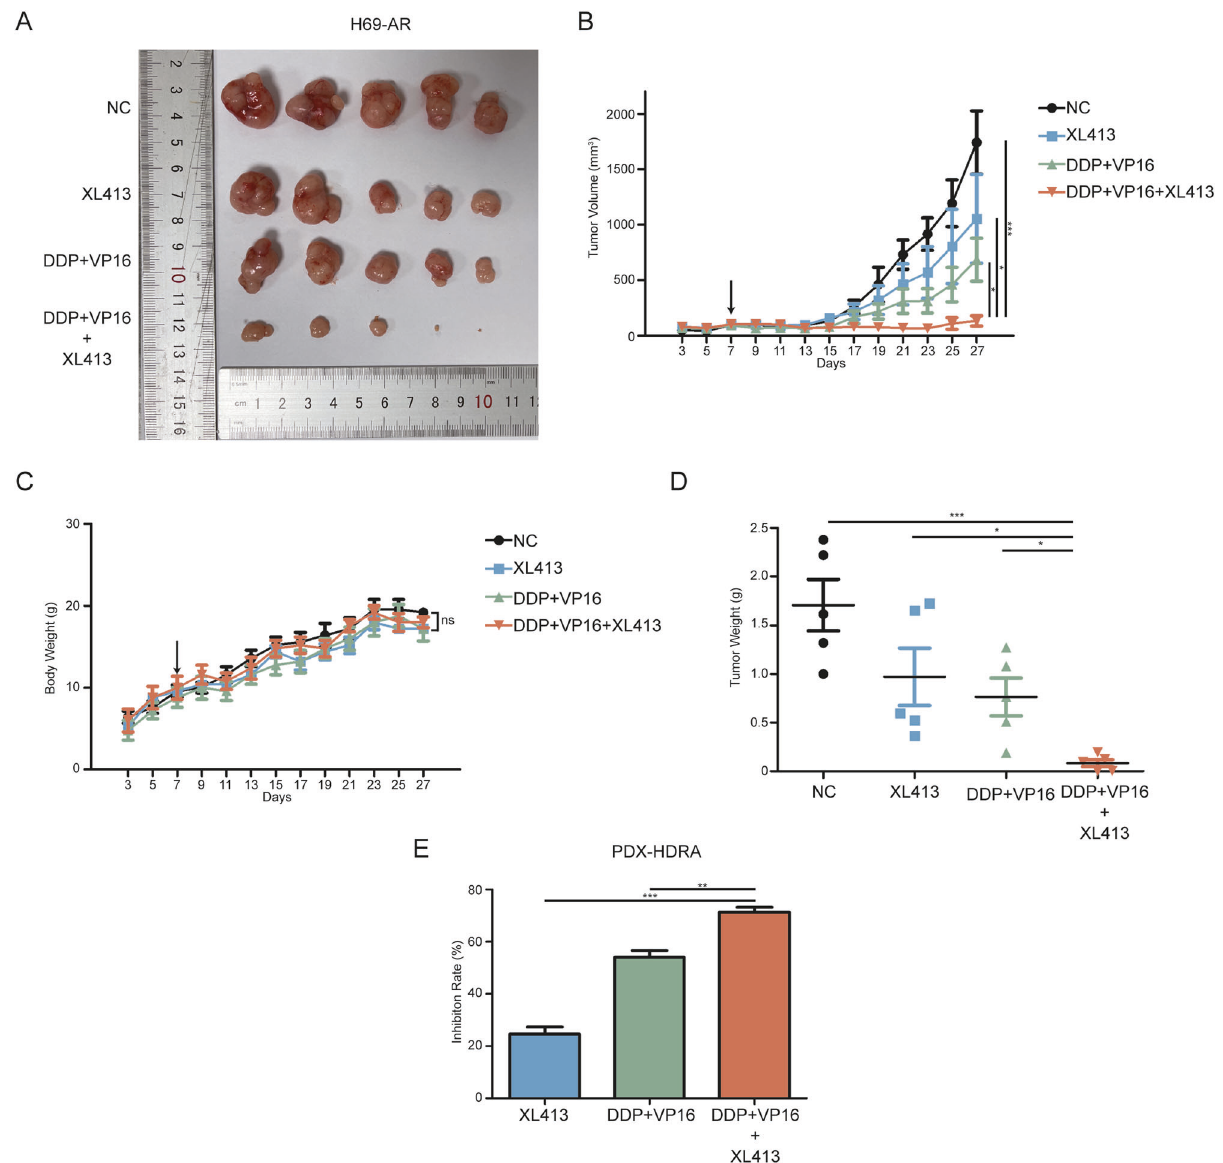
Fig. 6 Combined treatment of XL413 and chemo suppresses resistant SCLC tumor growth in vivo. A Images of H69-AR xenograft tumors after XL413 (20 mg/kg) and chemo-therapy (2.5 mg/kg DDP and 4 mg/kg VP16) alone or combined treatment. B Tumor volume curve of xenograft tumors. The arrow indicated the start of treatments. C Body weight curve of H69-AR xenograft mice. The arrow indicated the start of treatments. D Tumor weight scatter plot of H69-AR xenograft model. E Inhibition rate of XL413 and chemo-therapy alone or combined treatment calculated via PDX